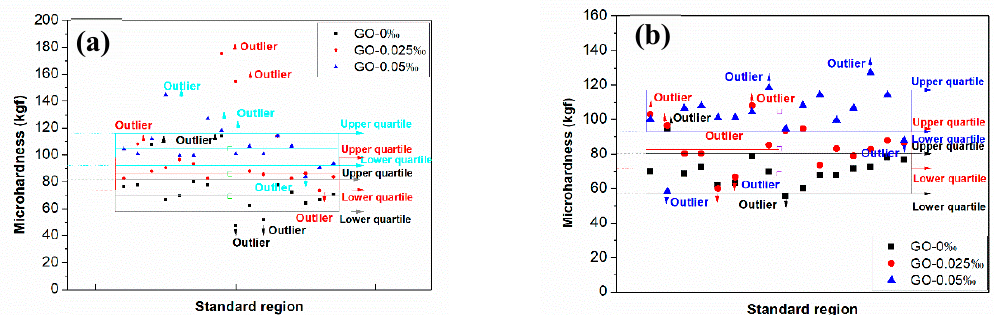
Figure 6. Microhardness distributions in a standard region of ( a ) GONM; ( b ) GORM specimens with varied w GO .